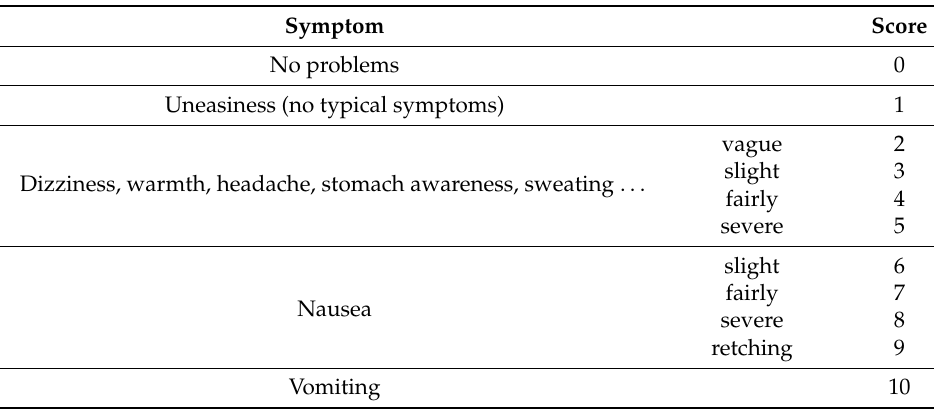
Figure 3. Illustration of the construction of the eye tracker used in our experiment [45].